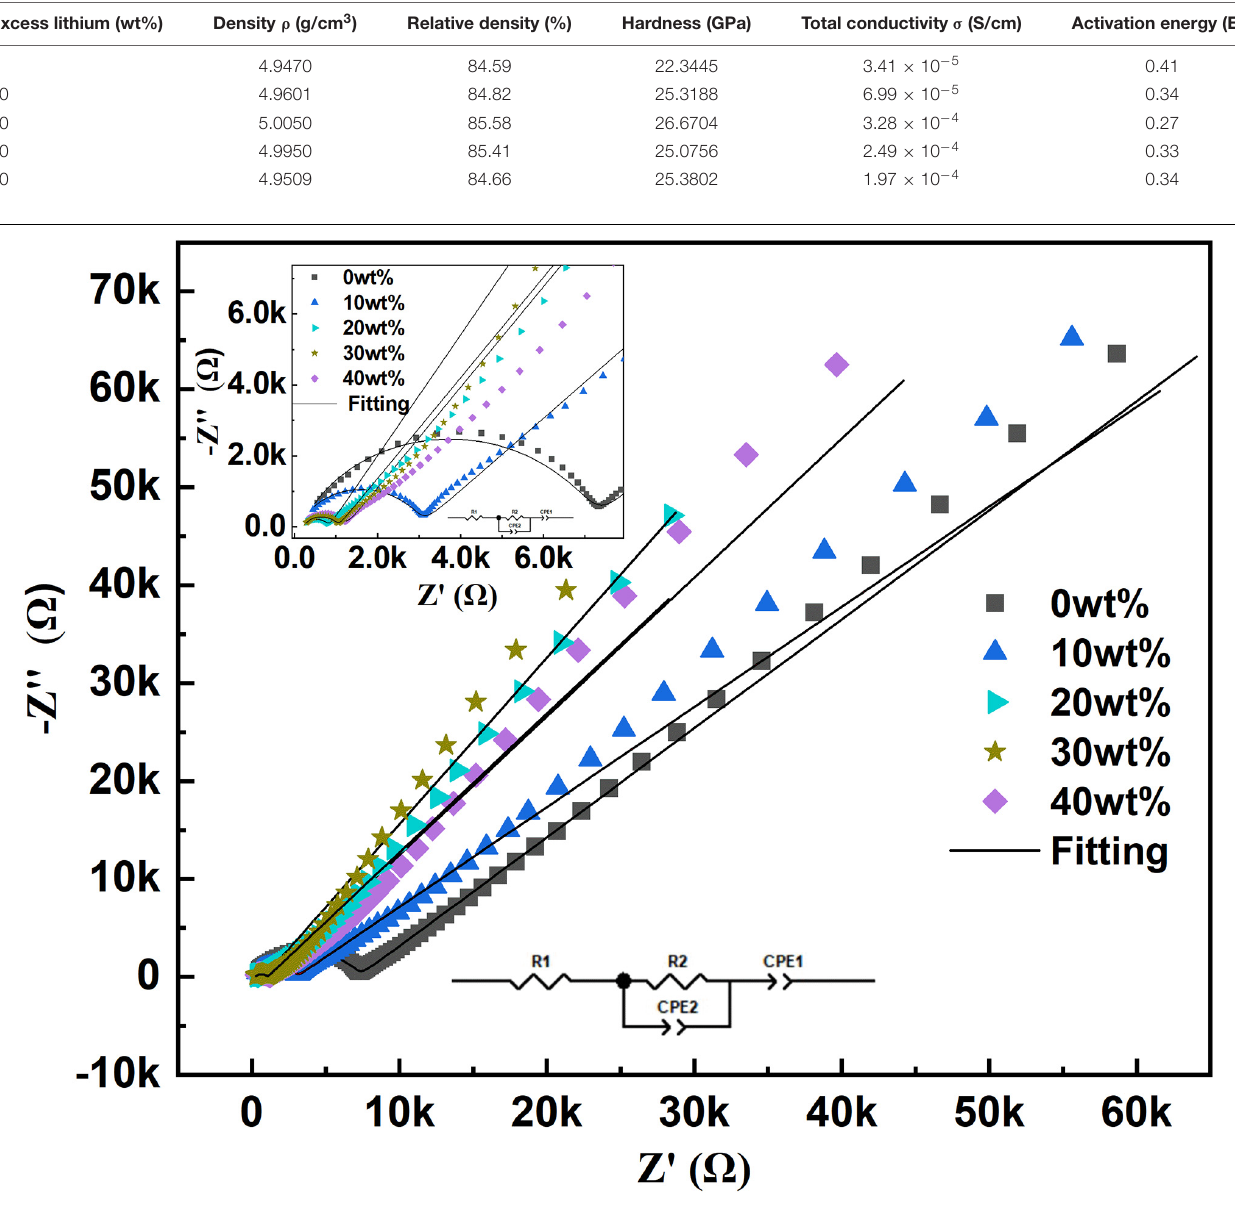
FIGURE 3 | AC impedance plots of LTPO with different excess lithium